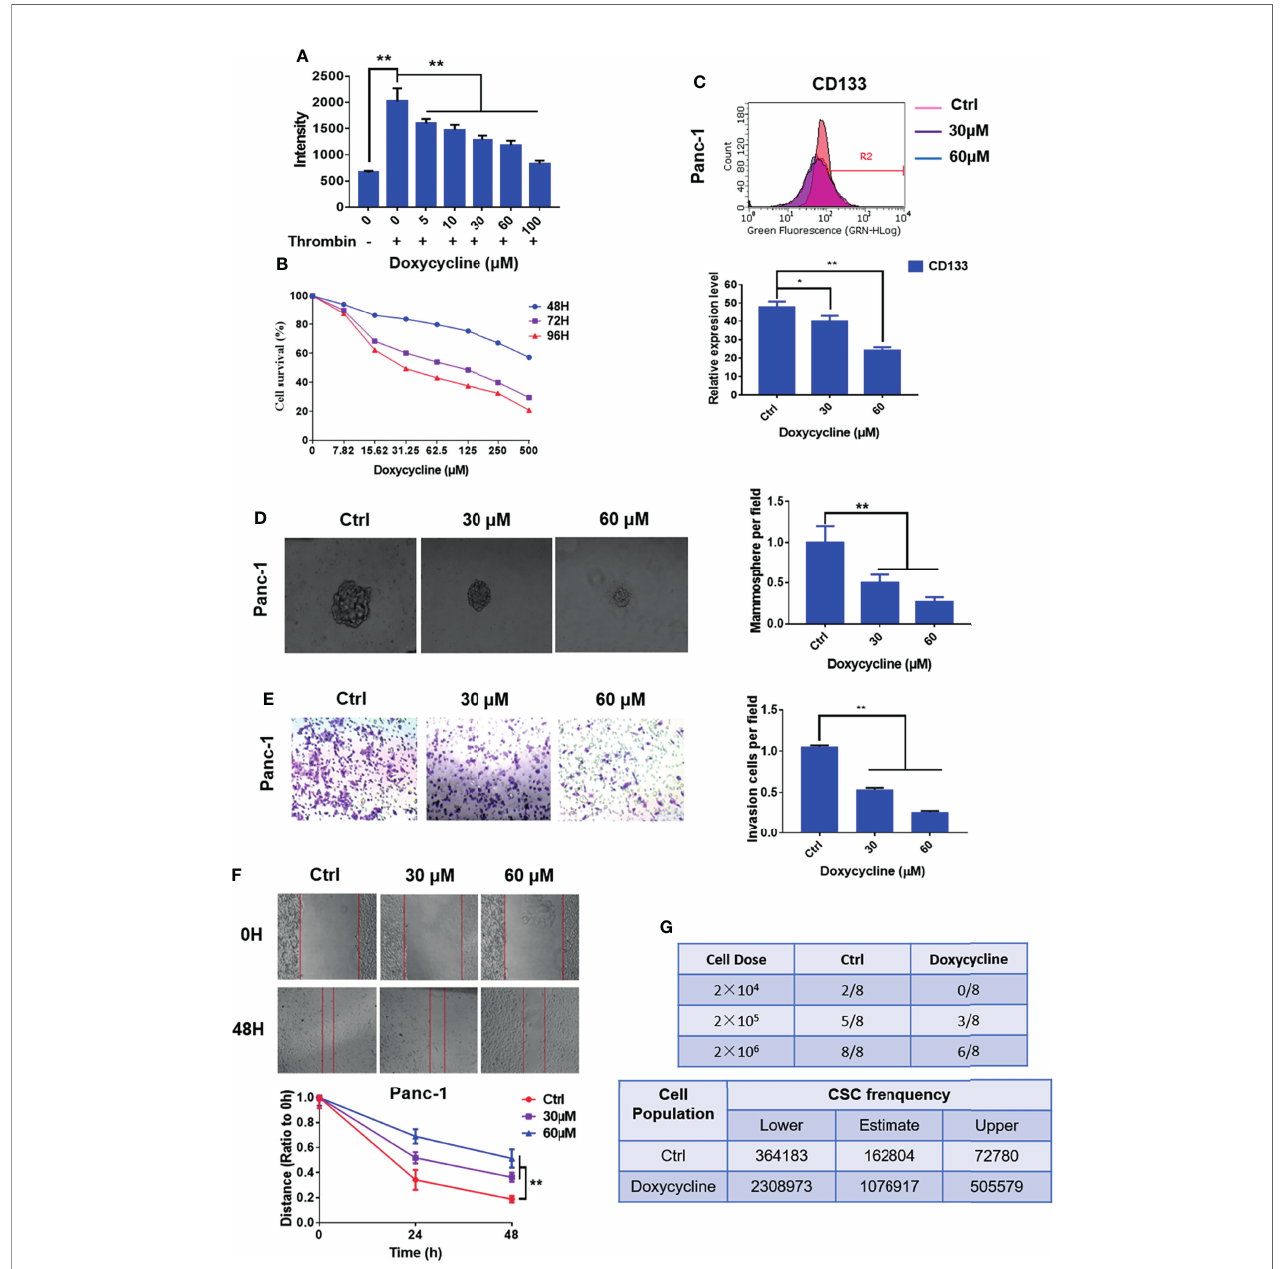
FIGURE 5 | Doxycycline inhibits the cancer stem cell-like properties of pancreatic cancer cells. (A) Effect of doxycycline on PAR1 activation stimulated by thrombin in pancreatic cancer cells detected by the Ca2+-mobilization assay. (B) Effect of doxycycline on pancreatic cancer cell viability after 48, 72, and 96 h treatment. (C) Effect of doxycycline on pancreatic cancer stem cell marker CD133 in Panc-1 cells. (D) Effect of doxycycline on the mammosphere formation of Panc-1 cells. (E) Effect of doxycycline on pancreatic cancer cell invasion ability. (F) Effect of doxycycline on pancreatic cancer cells migration ability. (G) Limiting dilution assay of pancreatic cancer stem cell from Panc-1 cells after treatment with doxycycline in node mice (n = 8). Cancer stem cell frequency was determined by ELDA. Data are shown as the mean ± SD (*P < 0.05, **P <